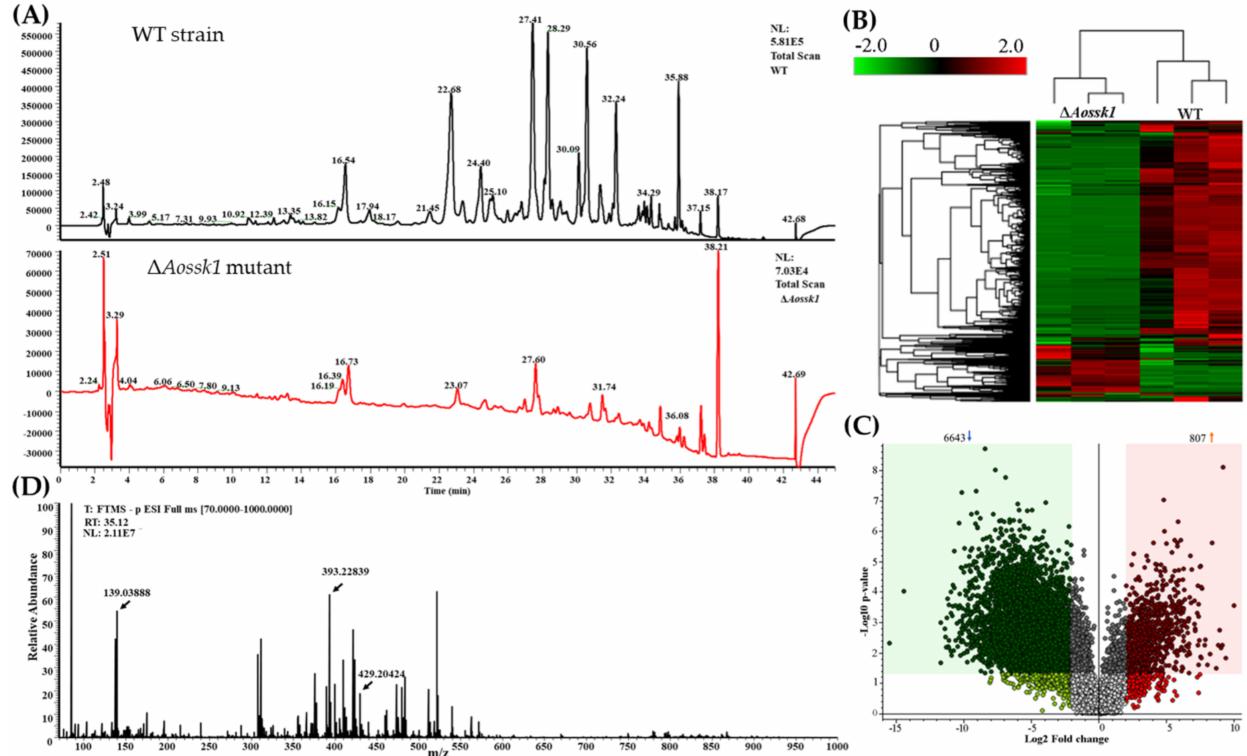
Figure 7. Comparison of metabolic profiling between WT and ∆ Aossk1 mutant strains. ( A ) Compar- ison of high-performance liquid chromatography profiles of the WT and ∆ Aossk1 mutant strains. ( B ) Heatmap of upregulated and downregulated metabolic pathways between ∆ Aossk1 mutant and WT strain determined via KEGG enrichment. ( C ) Volcano plot of differential metabolites between ∆ Aossk1 mutant and WT strain. ( D ) Mass spectrogram of arthrobotrisins in the WT strain (diagnostic fragments ion at m / z 139, 393, and 429). RT = 35.12